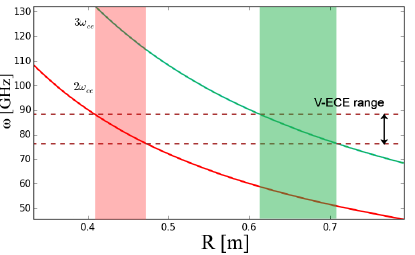
Figure 5. EC frequency profiles for B = 1 . 15 T and regions of thermal resonances of the 2 nd harmonic (red) and the 3 rd har- monic (green) inside the COMPASS